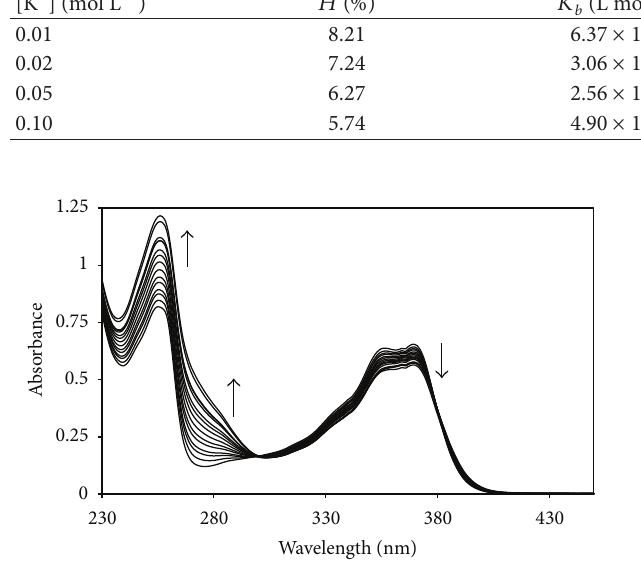
F 1: Absorption spectra of CPT-11 in the presence of ds- DNA at different